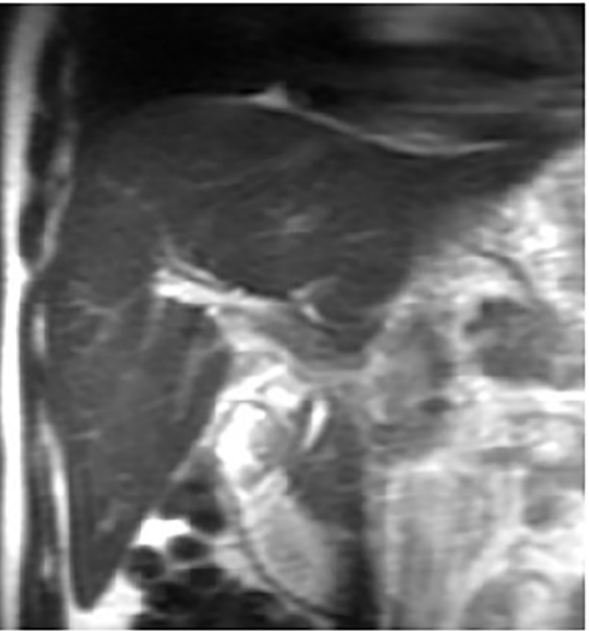
Fig 1. male, 61 years, diffuse hepatomegaly shown on coronal T2-weighted image.